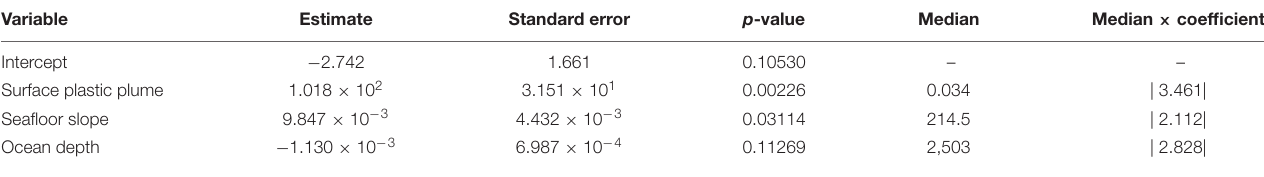
TABLE 3 | A summary of the best fit model (GAM) outputs for the explanatory variable effect on MP counts.